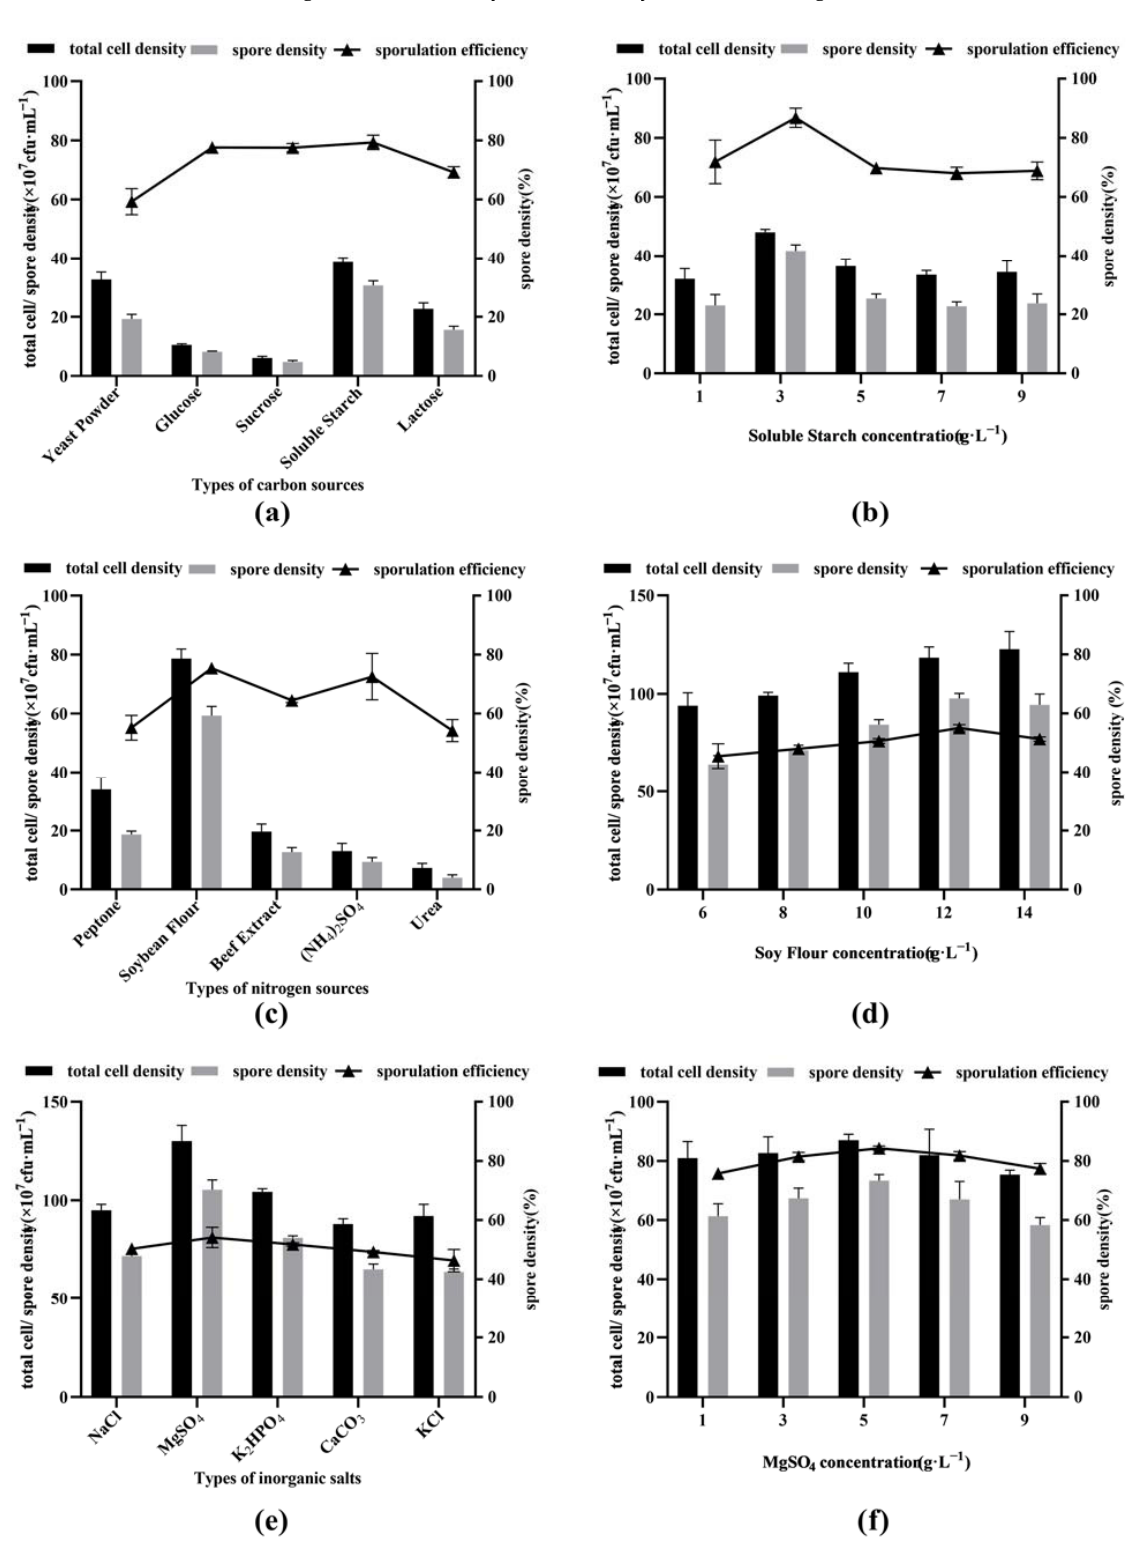
Figure 1. Screening of different carbon sources: ( a , b ), nitrogen sources ( c , d ), and inorganic salts ( e , f ) in medium.